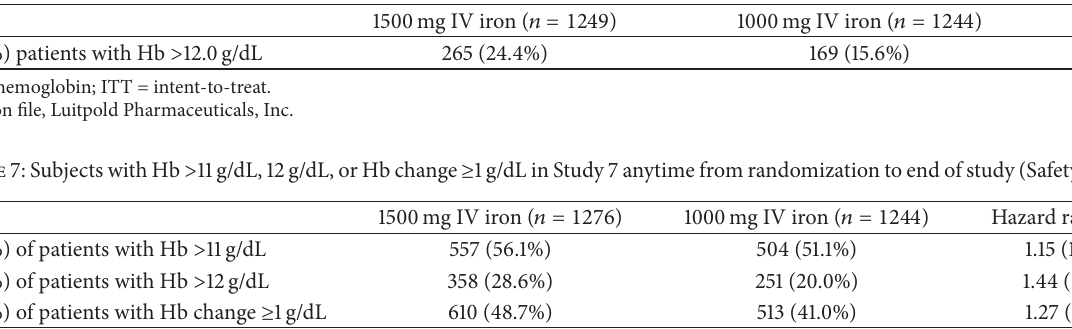
Table 6: Hb > 12g/dL and end of treatment (Day 56) from clinical Study 7 (ITT population).